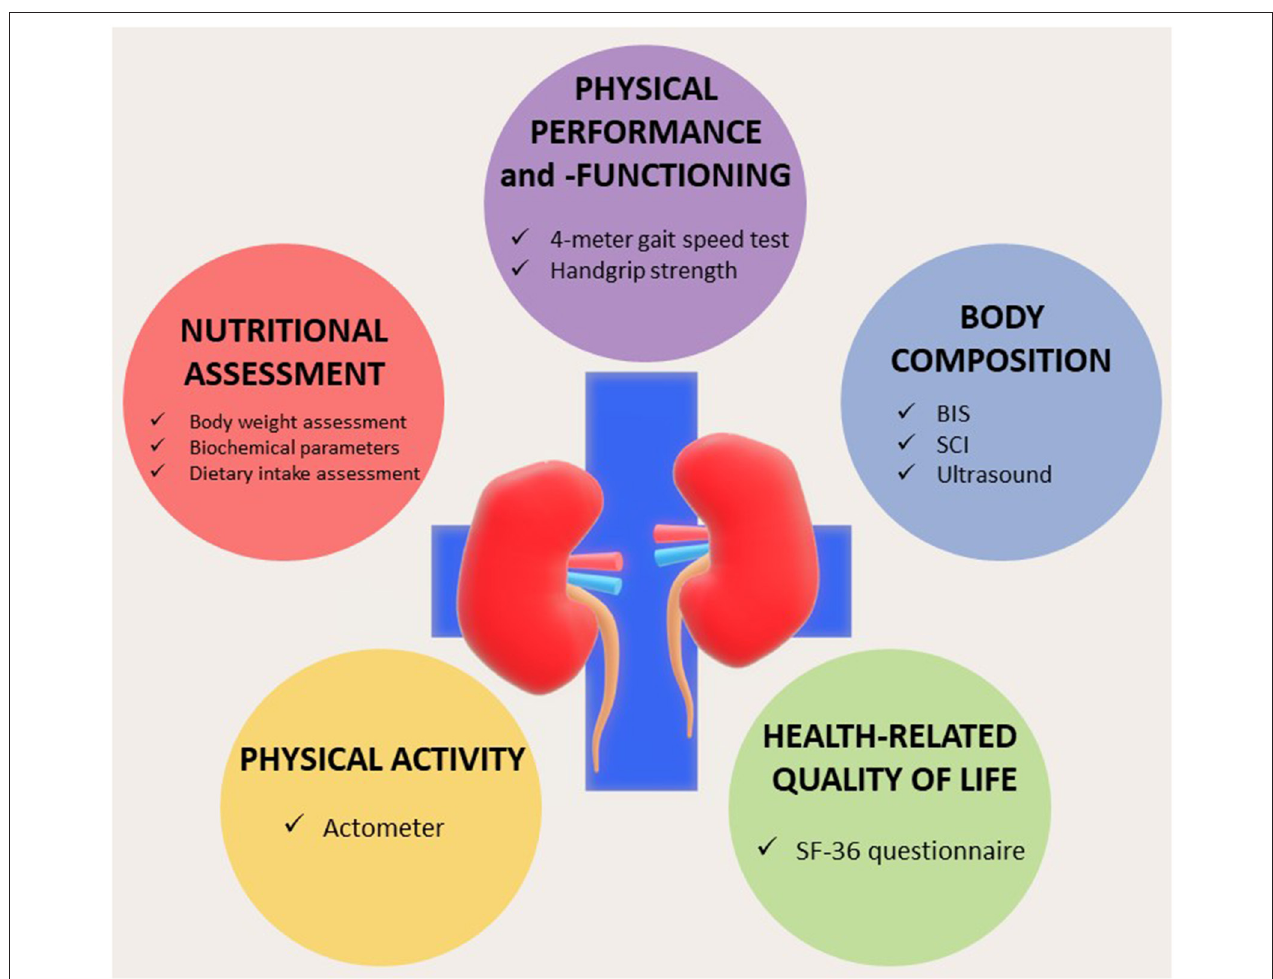
FIGURE 3 | Dashboard summarizing the integrated nutritional assessment of patients with chronic kidney disease (CKD)/end-stage kidney disease (ESKD). BIS, bioelectrical impedance spectroscopy; SCI, simplified creatinine index. Modified from Broers et al. ( 8) under Creative